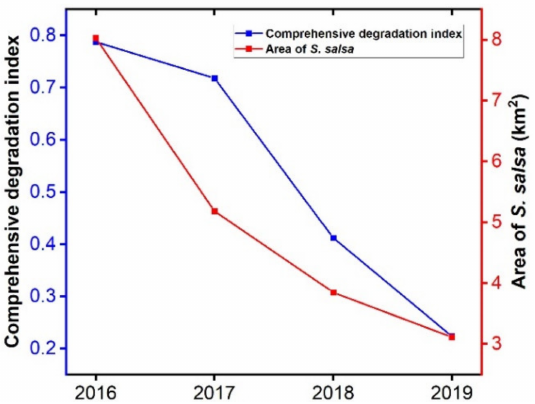
Figure 5. Comprehensive health index and area of S. salsa in wetlands from 2016 to